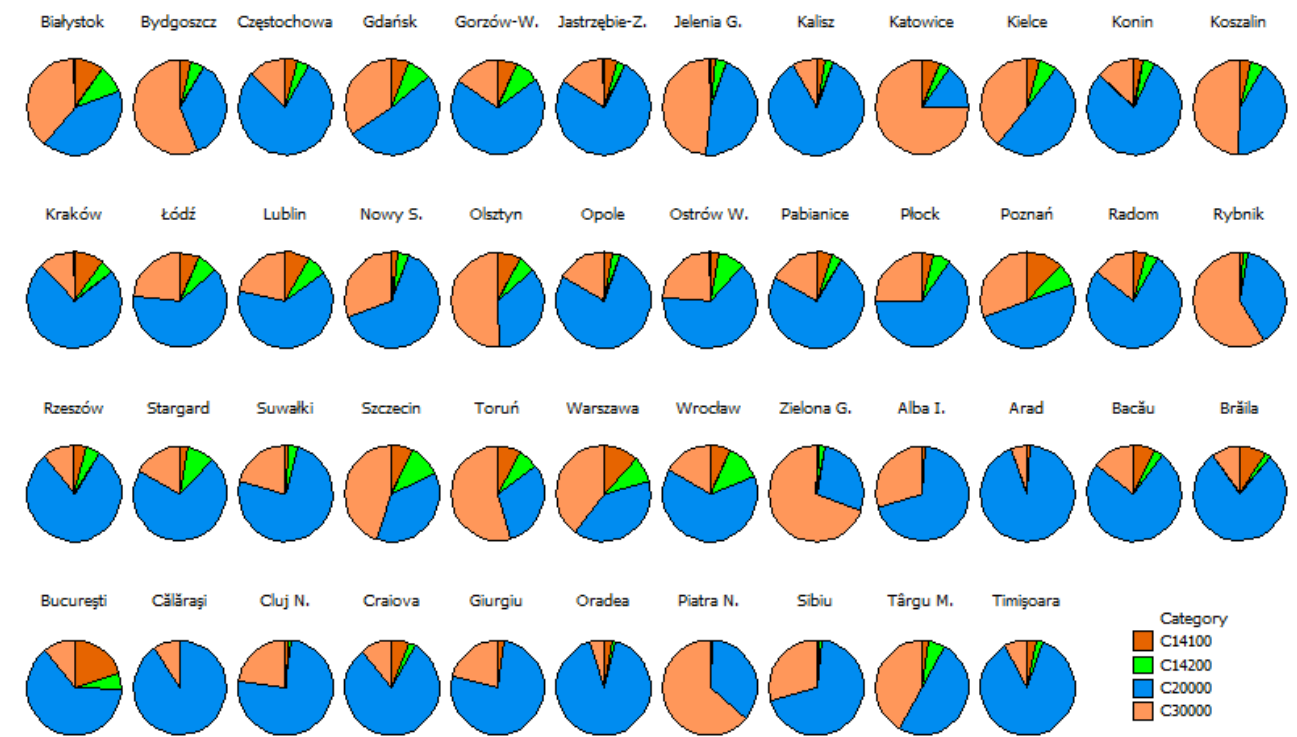
Figure 3. Distribution of the GI across the different categories (14100—green urban areas, 14200—sports and leisure, 20000—agricultural areas, and 30000—natural and (semi-)natural areas) in Romanian and Polish cities covered by Urban Atlas data. The graph is built based on the average values in 2006, 2012, and 2018, respectively. Table 3. Variables influencing the gain and loss of GI categories in Romanian and Polish cities cov- ered by Urban Atlas data. The table displays the p value associated with each relationship, using the following notations: Bold —significant, p ≤ 0.05; Italic —significant, p ≤ 0.1; Regular—not significant, p > 0.1.